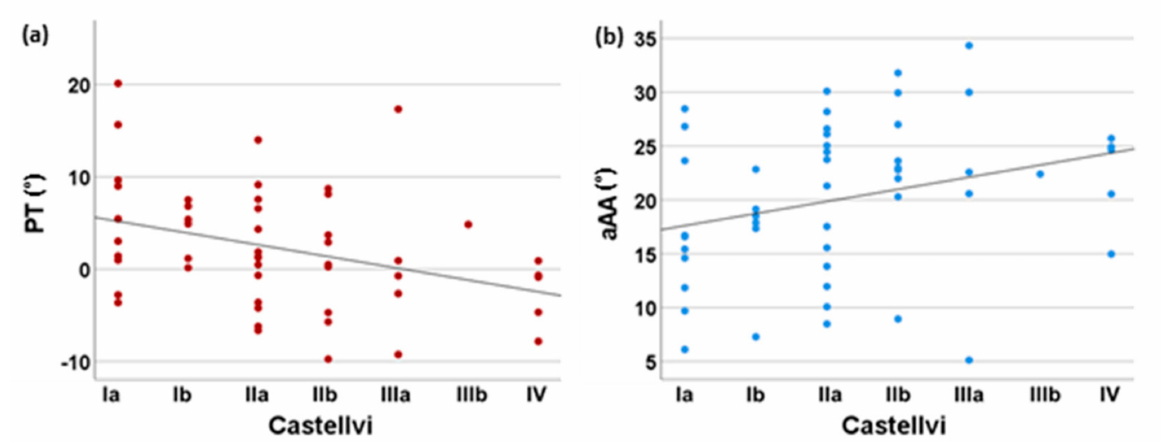
Figure 4. Influence of the Castellvi degree of LSTV on pelvic tilt and anatomical acetabular antever- sion. In ( a ), the significant negative correlation between the degree of LSTV according to Castellvi and the pelvic tilt is given. ( b ) Depicts the significant positive correlation between anatomical acetab- ular anteversion and the degree of LSTV according to Castellvi. LSTV = Lumbosacral transitional vertebrae, PT = pelvic tilt, aAA = anatomical acetabular